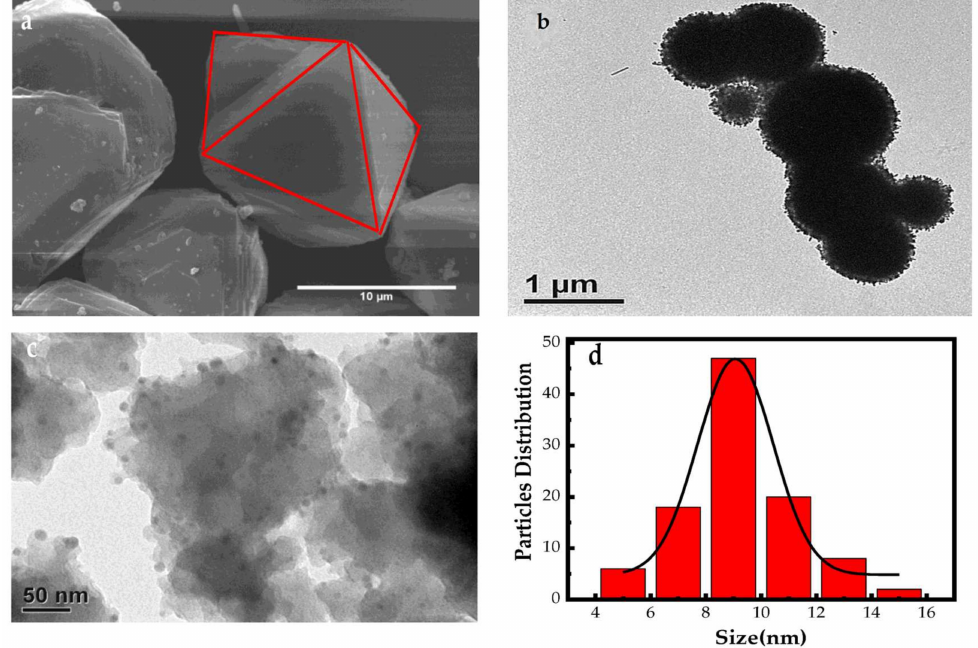
Figure 1. ( a ) SEM images of Cu-MOF; TEM images of ( b ) Cu-MOF-urea and ( c ) Cu x O/MOF, and ( d ) histogram of the Cu x O nanoparticles onto